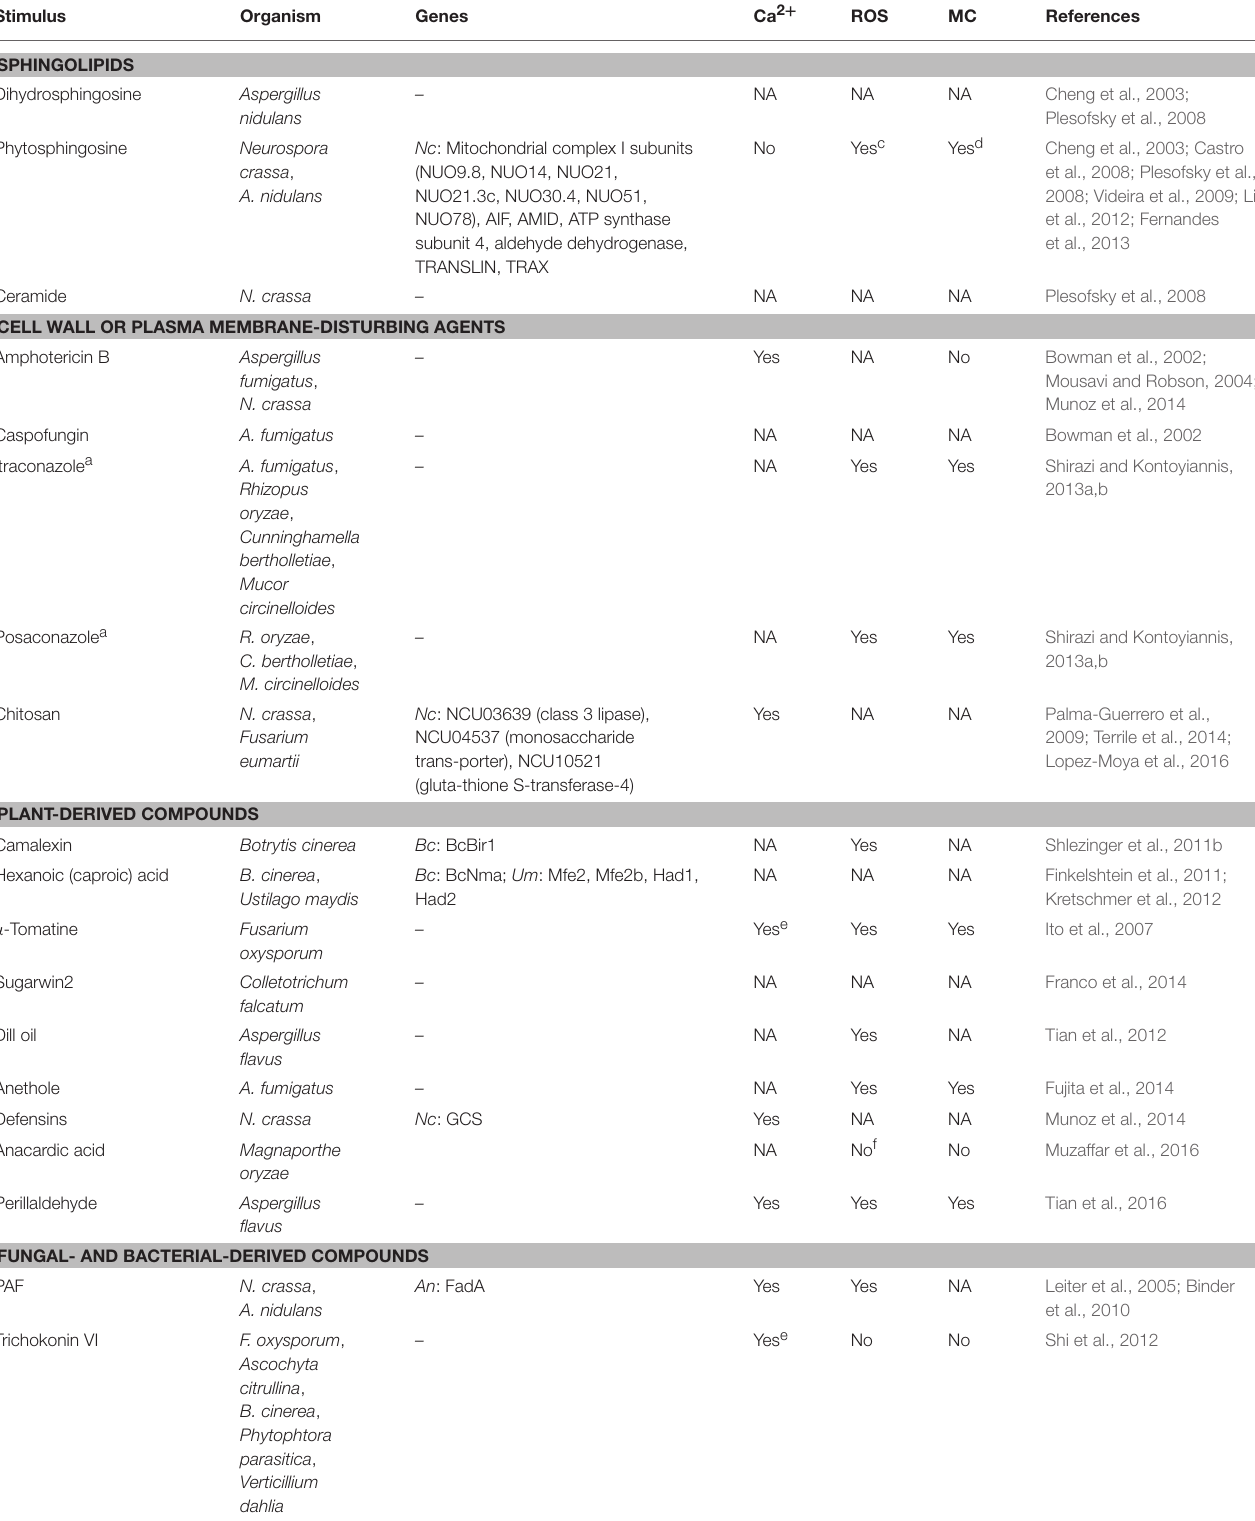
TABLE 2 | PCD in filamentous fungi exposed to cell death-inducing stimuli.